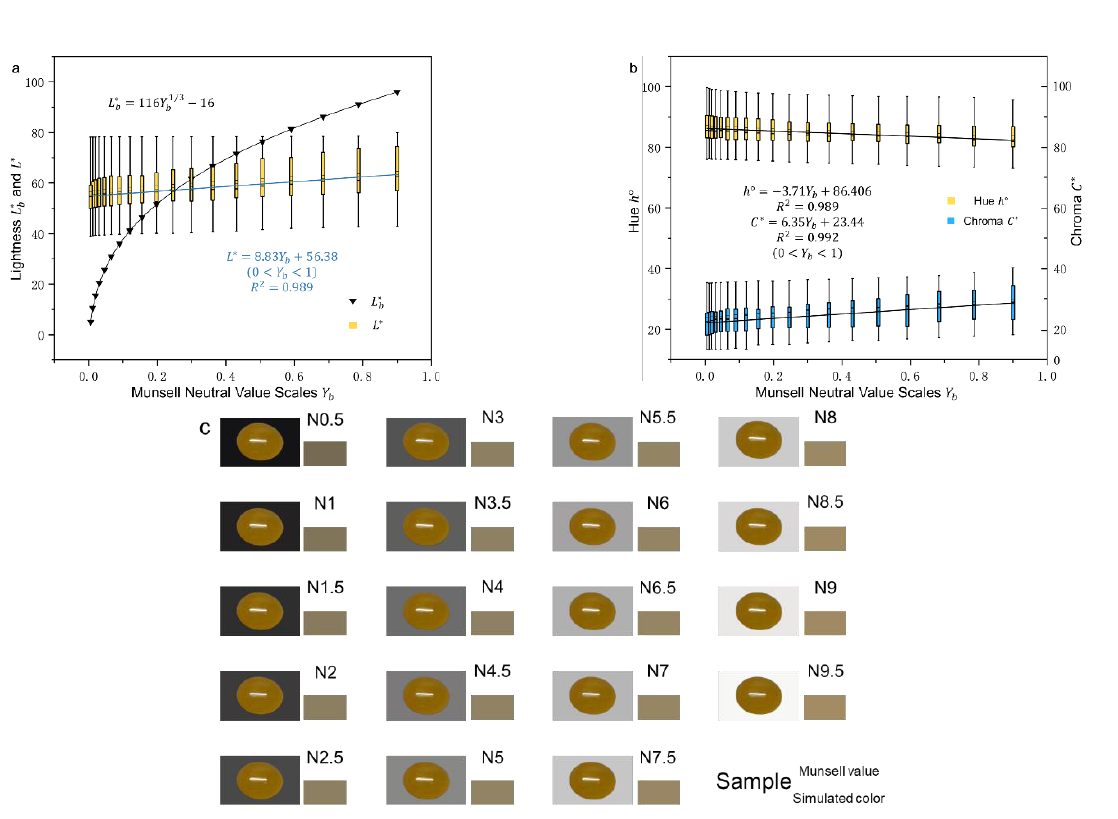
Figure 4. The variation of color is caused by the luminance factor. ( a ) Relation between the lightness of sample L* and background lightness L_b*. Data are shown in Supplementary Materials Table S1. ( b ) Correlation between Y_b and Hue h°, Chroma C*. Data are shown in Supplementary Materials Tables S2 and S3. ( c ) The picture of Y-Jade-421 on different backgrounds, associated with the value of background and simulated color.